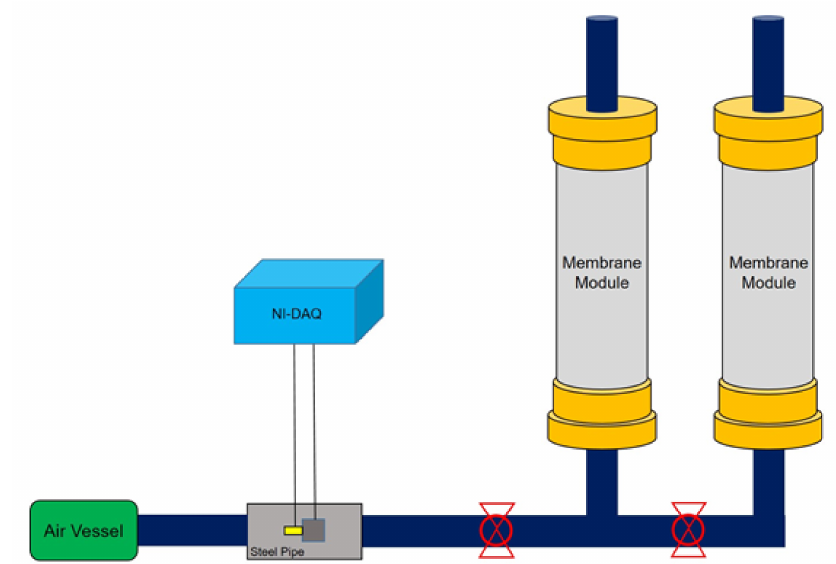
Figure 2. Scheme of test setup.